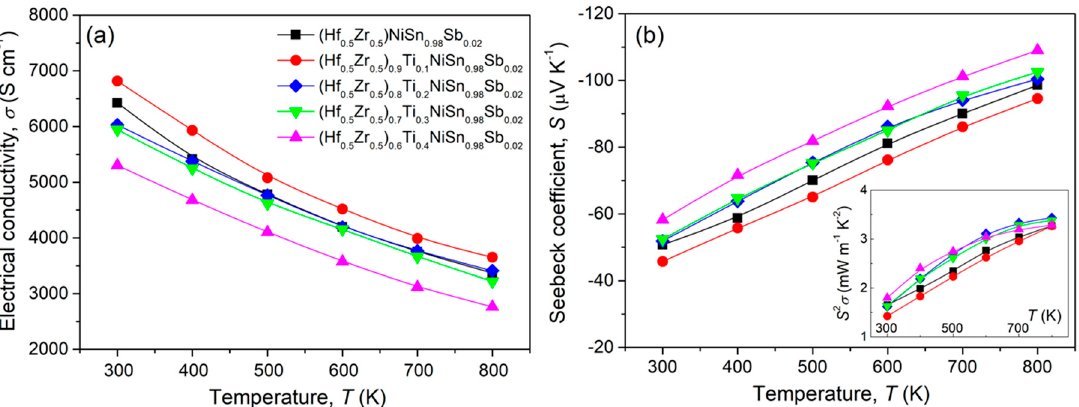
Figure 3. Temperature–dependent ( a ) electrical conductivity ( σ ) and ( b ) Seebeck coefficient ( S ) for the sintered bulks of (Hf 0.5 Zr 0.5 ) 1 − x Ti x NiSn 0.98 Sb 0.02 ( x = 0, 0.1, 0.2, 0.3, and 0.4). Inset of ( b ) is the temperature dependence of power factor ( S 2 σ ).